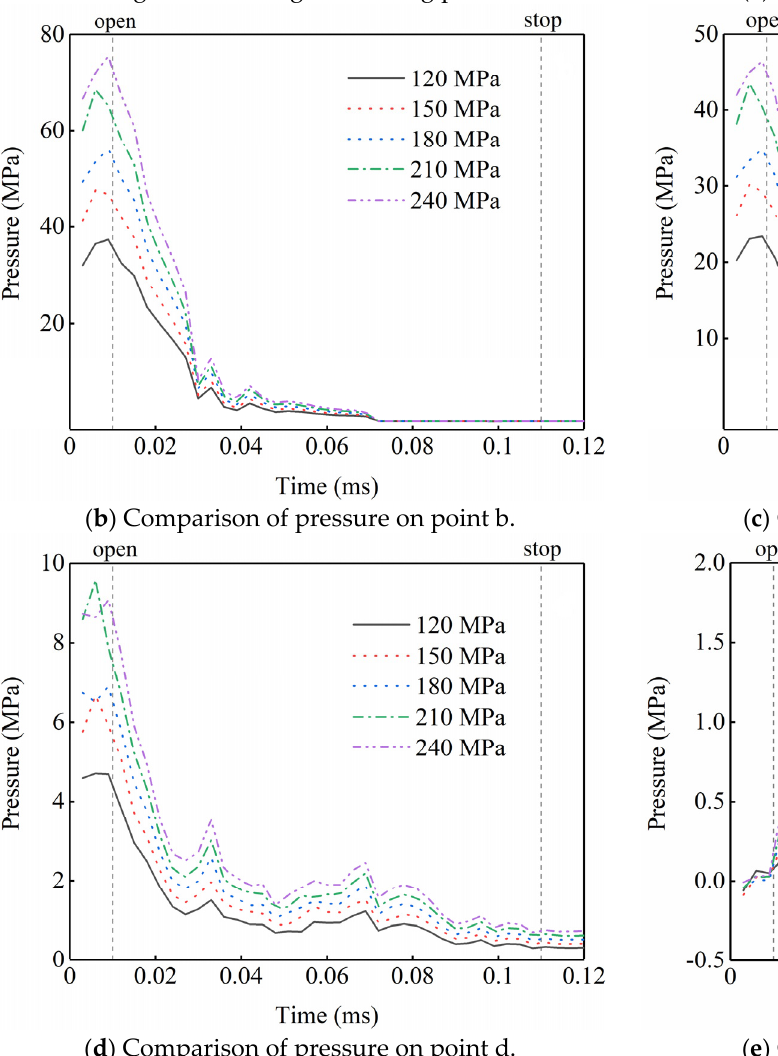
Figure 14. Time history curve of wall pressure at five points ( a – e ) on the sealing surface of the control